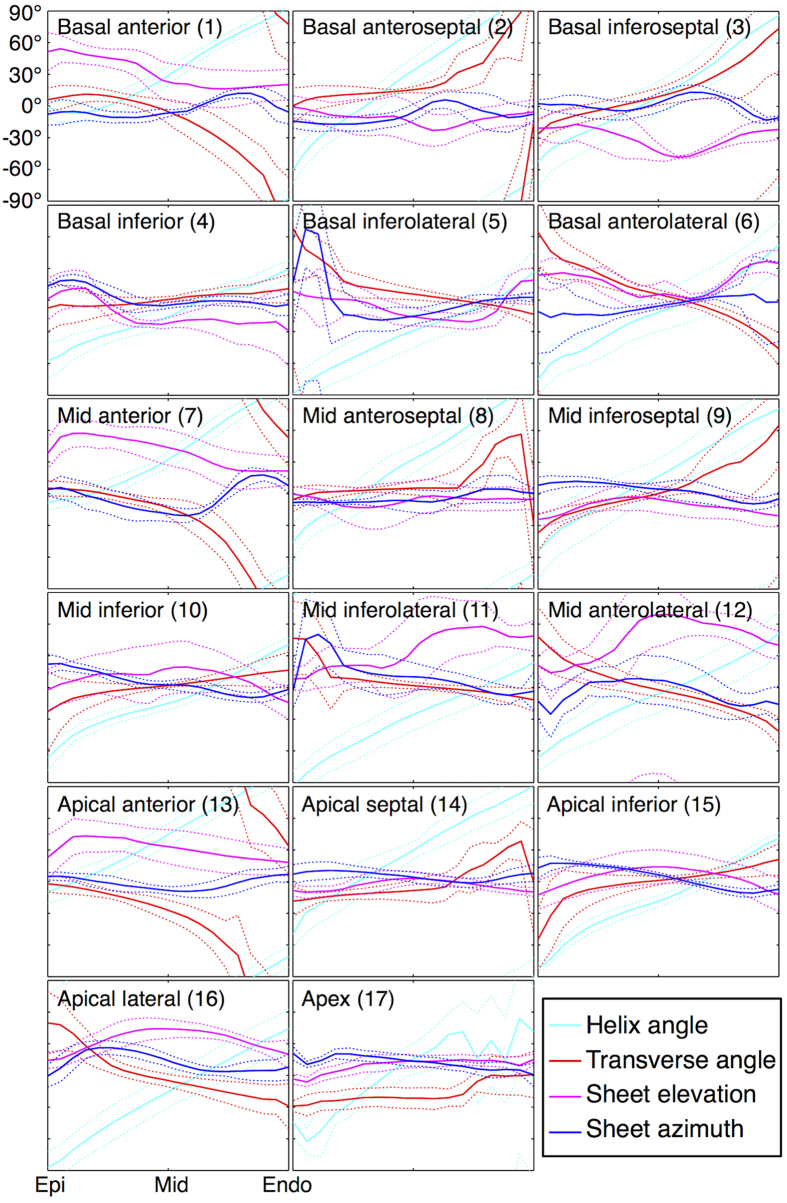
Transmural variation in helix angle, transverse angle, sheet elevation and sheet azimuth.Regions were defined by the 17-segment AHA model. Means (solid lines) and standard deviations (dotted lines) over the five hearts are given. Angles were normalised to wall thickness in each region.